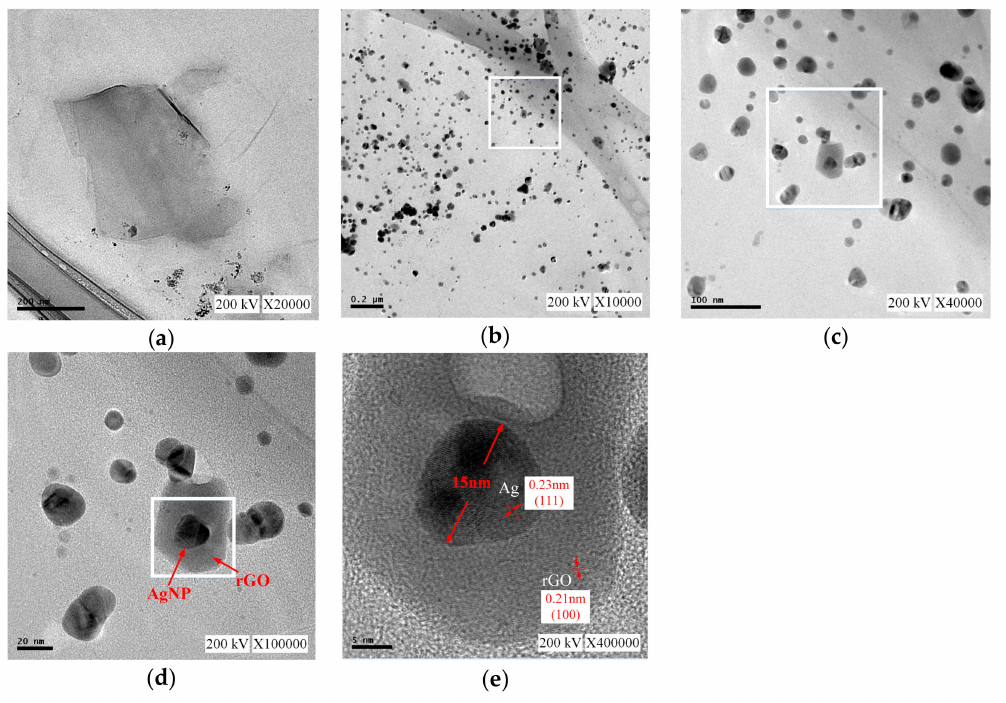
Figure 6. Transmission electron microscopy (TEM) images: ( a ) 200 nm, GO; ( b ) 0.2 µ m,